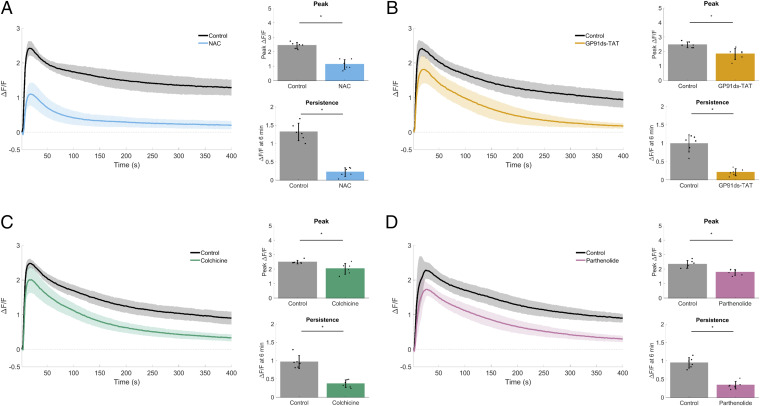
Microtubule-dependent mechanically activated NOX2-derived ROS sustains calcium signaling. For each dataset, traces show mechanically stimulated calcium signaling (ΔF/F) plotted over time for control and treated cells. Bar graphs show quantification of peak ΔF/F and ΔF/F at 6 min (persistence). (A) The reactive oxygen species (ROS) scavenger N-acetylcysteine (NAC) (40 mM) inhibited both peak ΔF/F and ΔF/F at 6 min compared with control. (B) The specific peptide inhibitor (GP91ds-TAT; 1.5 µM) of NADPH oxidase 2 (NOX2) resulted in a significant reduction of peak ΔF/F, with the largest inhibition seen in ΔF/F at 6 min. (C) The microtubule depolymerizer colchicine (200 µM) resulted in a significant reduction of peak ΔF/F, with the largest inhibition seen in ΔF/F at 6 min. (D) Inhibition of the stabilizing microtubule posttranslational modification detyrosination using parthenolide (200 µM) resulted in a significant reduction of peak ΔF/F, with the largest inhibition seen in ΔF/F at 6 min. The collective data identify the key components of the microtubule-dependent NOX2-ROS mechanotransduction pathway (i.e., X-ROS) and are necessary for sustaining long-term (persistent) mechanically activated calcium. Data are presented as mean ± SD. The asterisk (*) indicates significance from control, P < 0.05 via paired t test. Data represent n = 6 in total from six independent experiments for each group. Control groups were collected separately for each dataset.